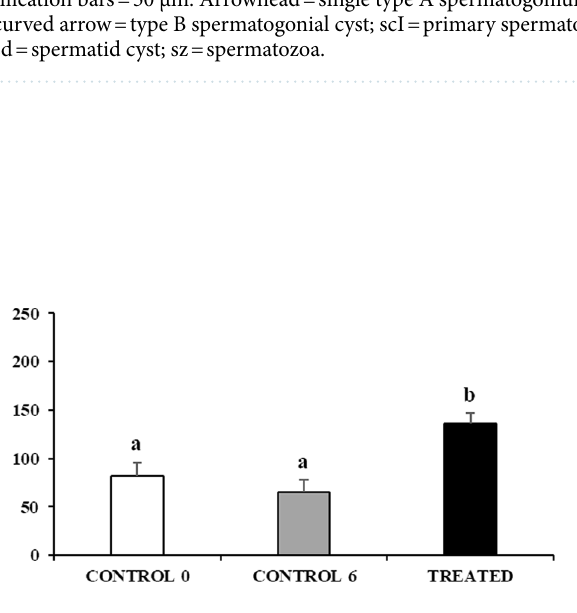
Figure 4. Mean (± sd) diameter of seminiferous tubules of untreated (CONTROL 0, n = 5), treated with saline solution for 6 weeks (CONTROL 6, n = 9) or treated with rFsh for 6 weeks (TREATED, n = 4) juvenile meagre males. Different letters represent statistically significant differences (ANOVA; P <